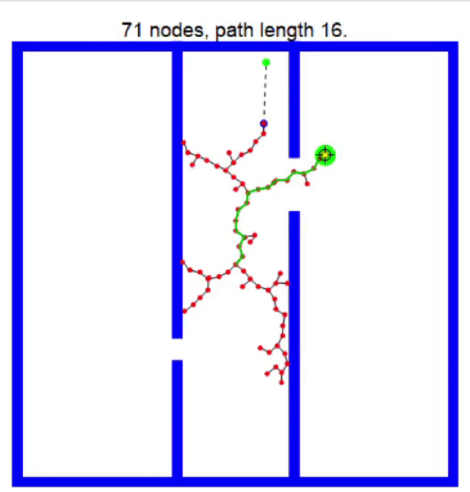
Figure 3. Exploration of rapidly-exploring random tree are designed to efficiently explore paths in a high-dimensional space